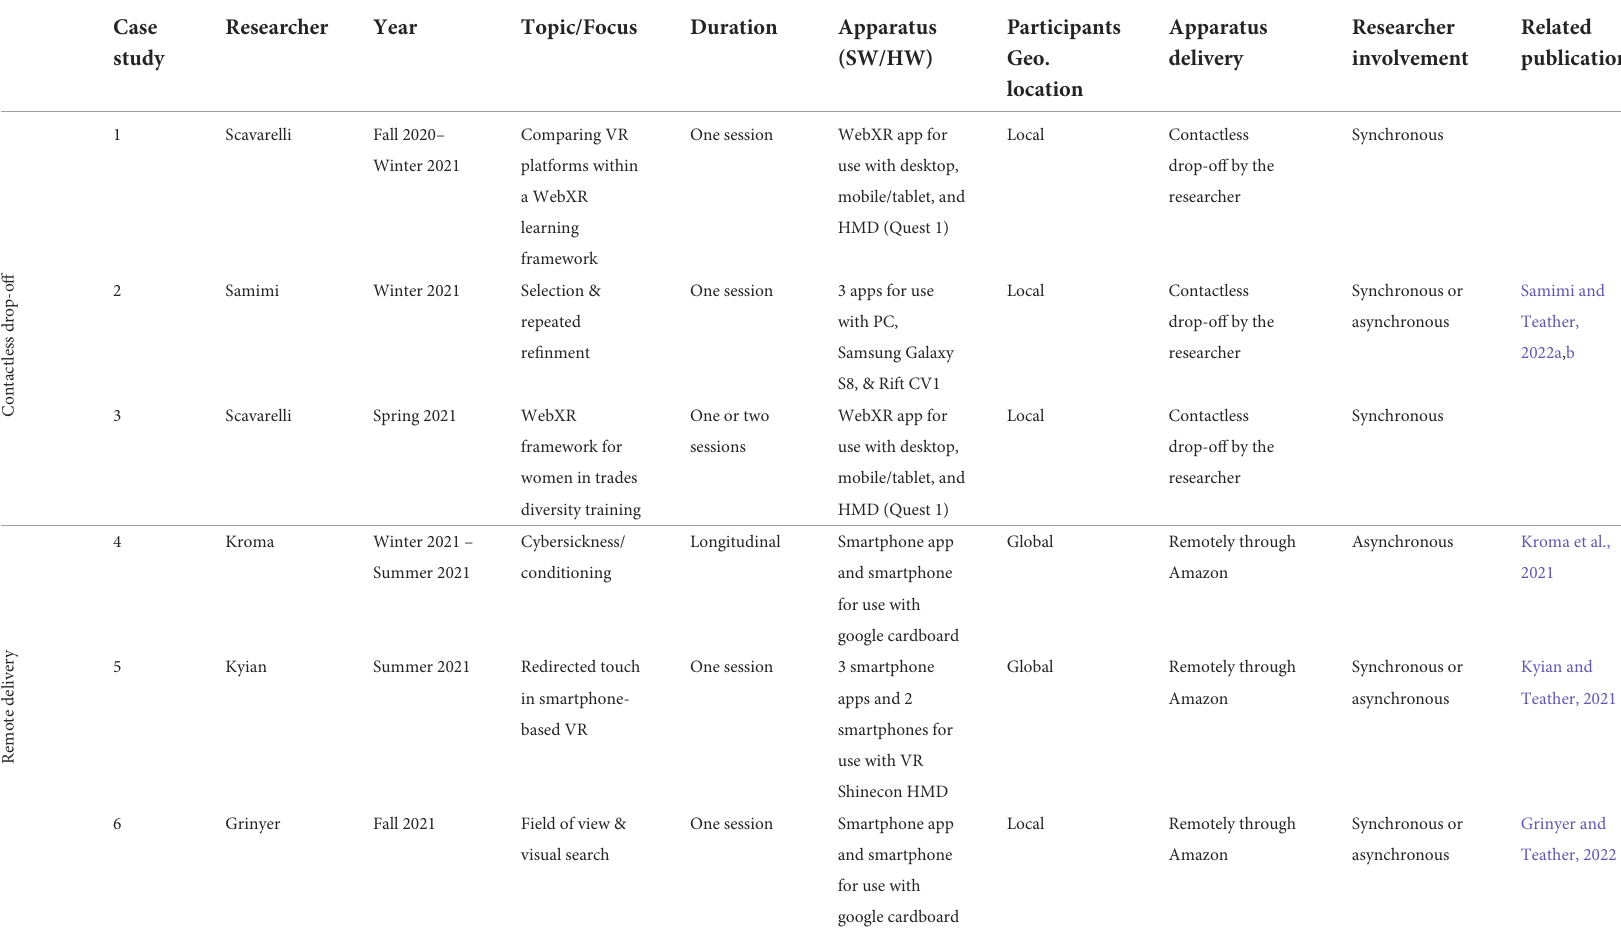
TABLE 1 Comparative summary of the examined XR remote